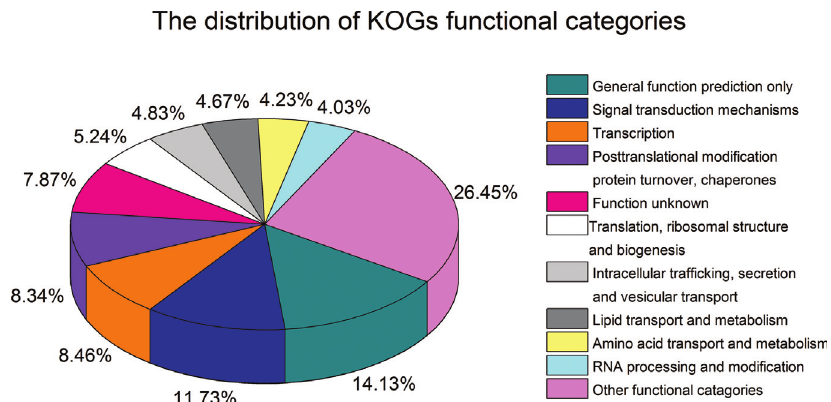
Figure 3 - Clusters of orthologous group (KOG) classification.